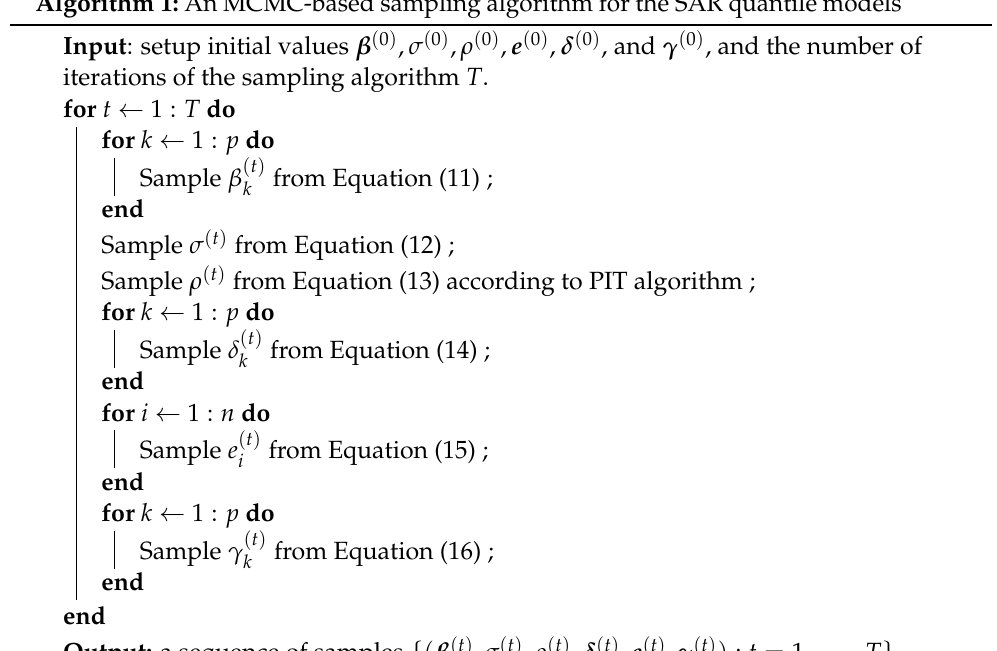
Algorithm 1: An MCMC-based sampling algorithm for the SAR quantile